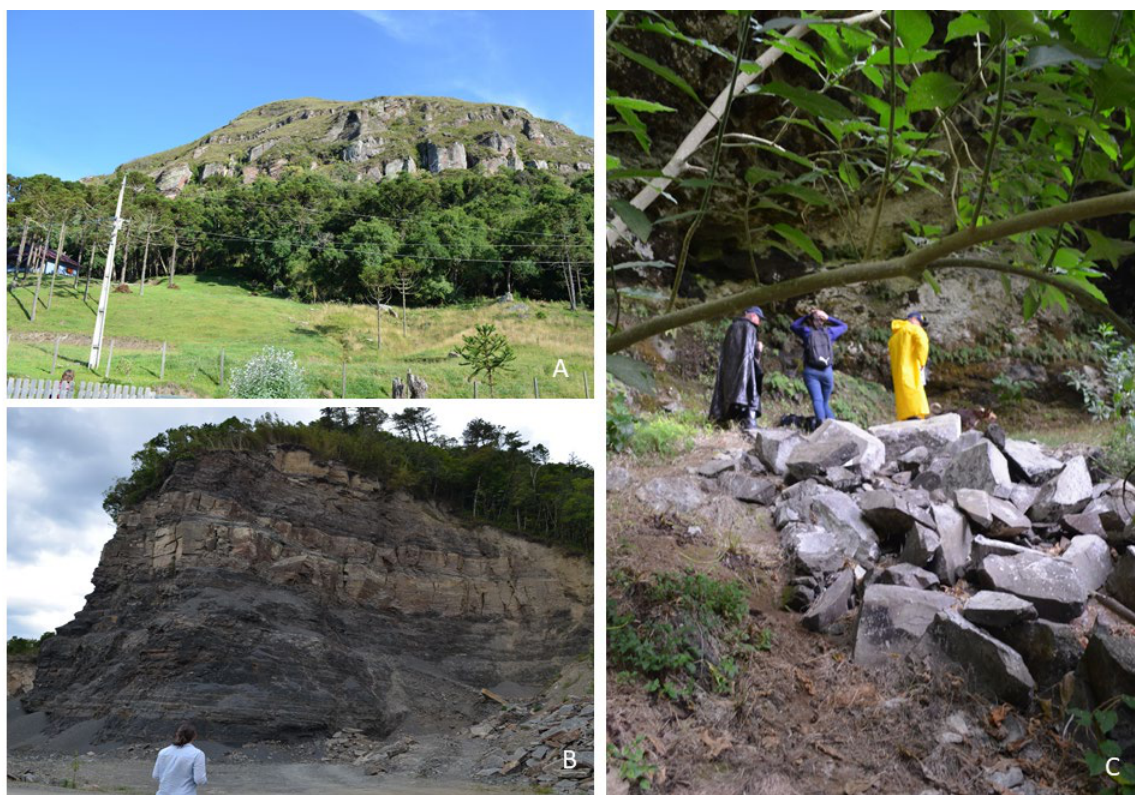
Figure 7. A: exposed basalts in a typical hillside in Urubici County (Santa Catarina State). B: basalt bedrock under the topsoil of the forest (~ 30 cm thick), exposed by mechanical excavation (Bom Retiro County, Santa Catarina State). C: fallen rocks (basalts) (Lava Tudo river, Urubici County, Santa Catarina State).